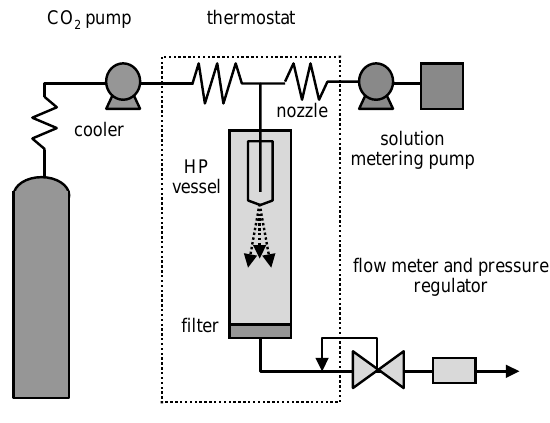
Experimental system for particle formation using super- critical CO 2 as an